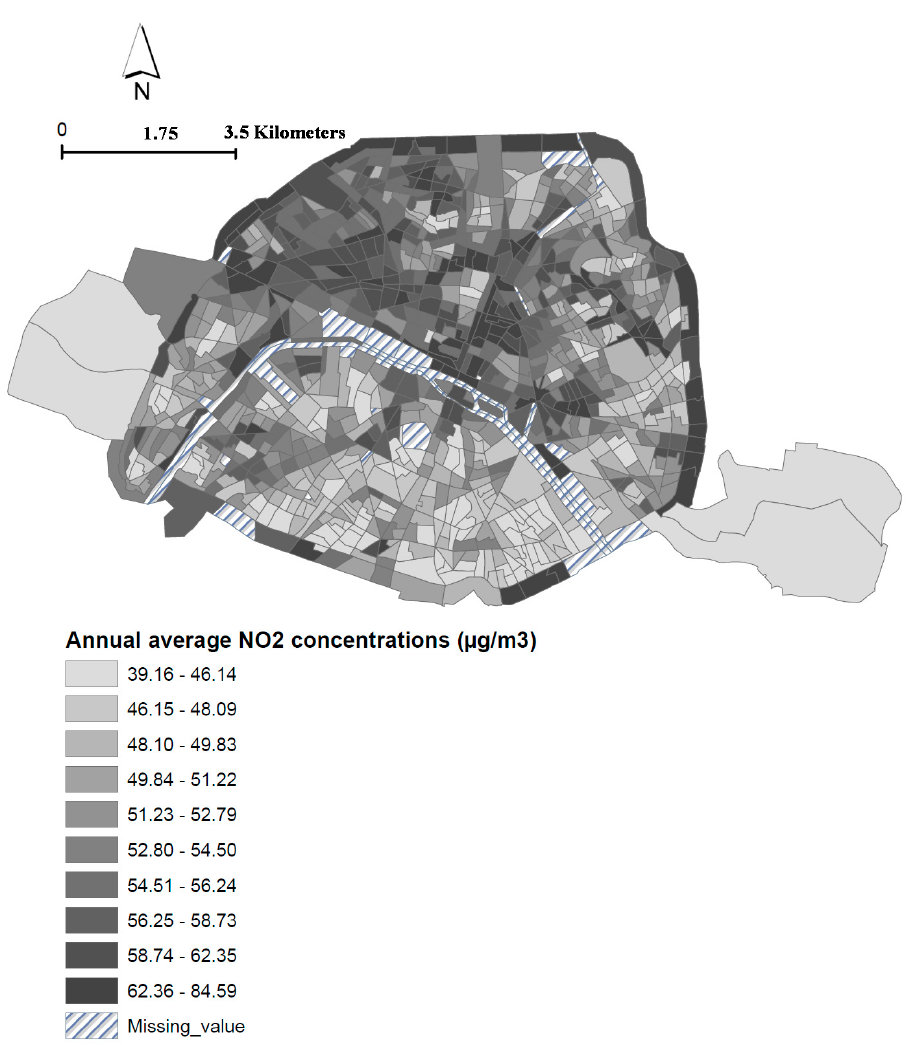
Figure 1. Spatial distribution of the annual average NO 2 concentrations according to the deciles of its distribution, at the census block level, Paris city (Period: 2004–2009).